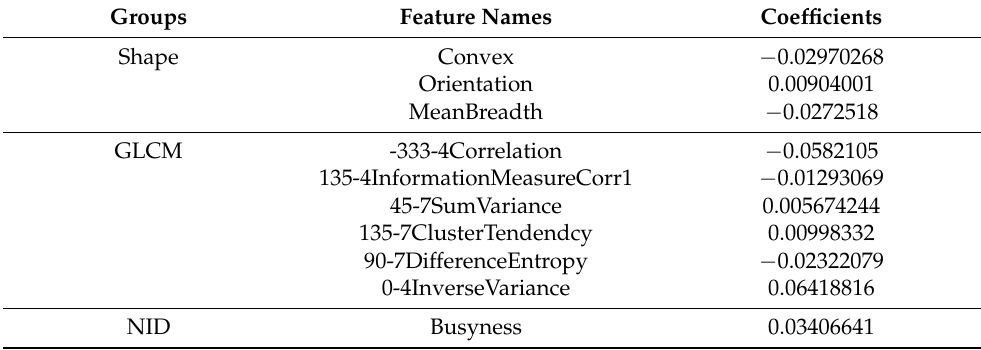
Table 3. Feature selection by LASSO regression. (Top